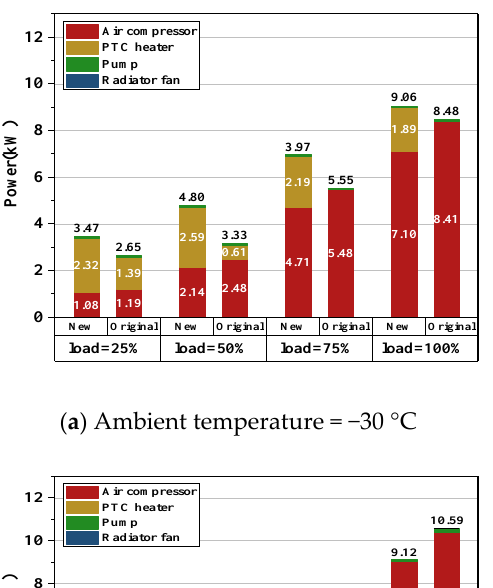
Figure 10. LH 2 cold energy utilization ratio results: ( a ) Cold energy utilization ratio as a function of ambient temperature and FC load; ( b ) Cold energy utilization system contour map.